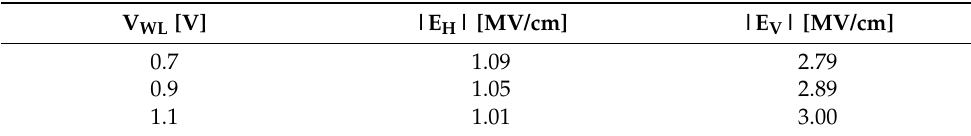
Table 2. TCAD simulated E H and E V absolute values calculated in x = X FG and y = 0 as functions of V WL .